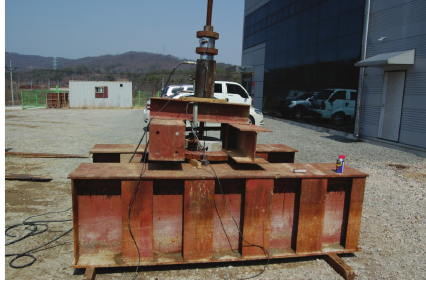
Figure 4: Set-up of the specimen for the bond capacity test.